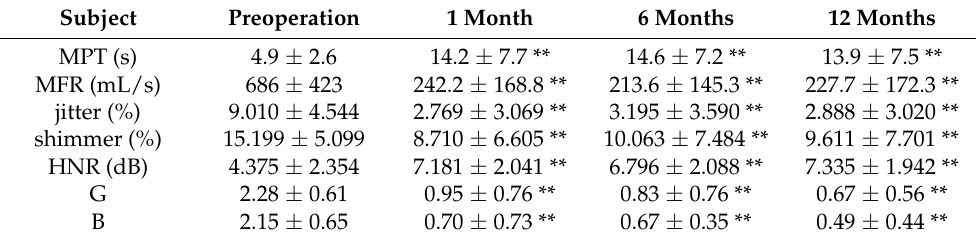
Table 4. The average values of each parameters in phonosurgery